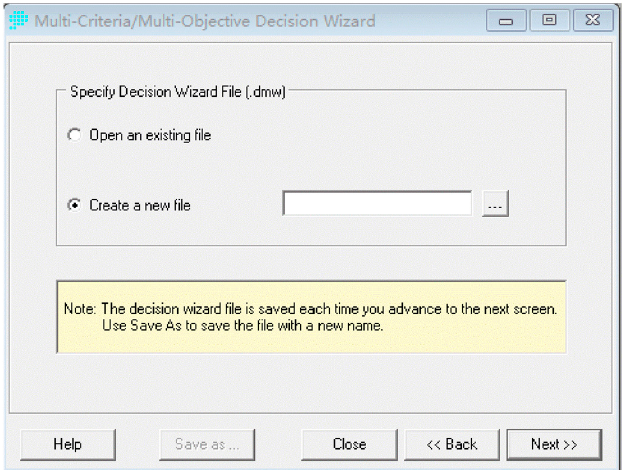
Figure 8. Suitability maps of farmland ( a ), forestland ( b ), grassland ( c ), water ( d ), built land ( e ) and unused land ( f ).